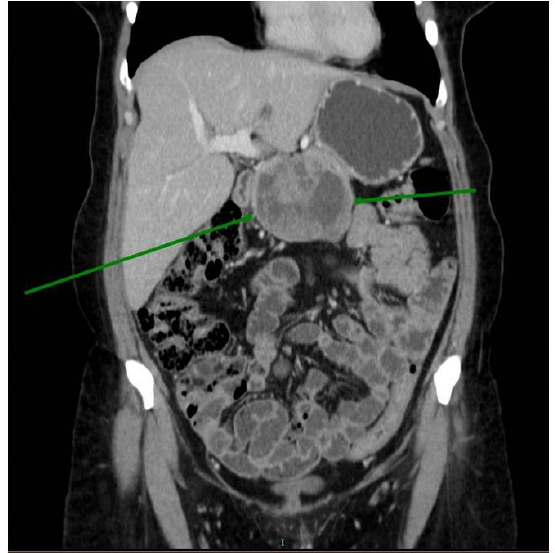
Figure 2. Abdominal computed tomography (CT) showing a greendemarcated solid cystic lesion of 7 cm in the head of the pancreas (Green lines).